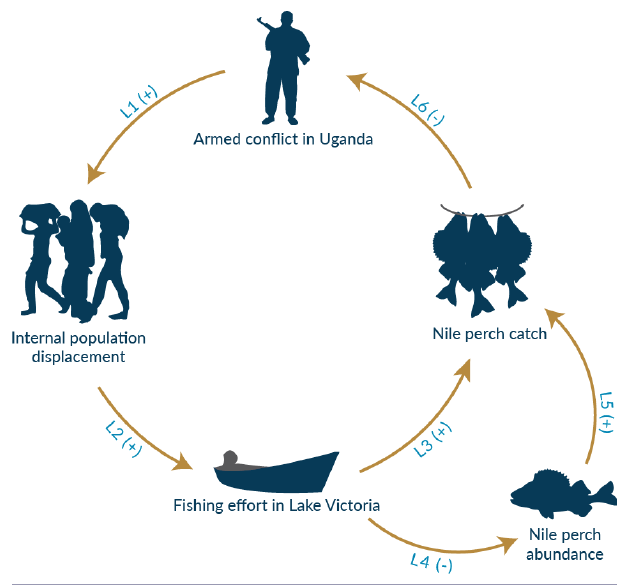
Fig. 4 . Possible links coupling armed civil conflict in Uganda to Lake Victoria fisheries. The sign represents the hypothesized direction of the bivariate relationship (i.e., the sign on the correlation coefficient) as detailed in the text and following figures.